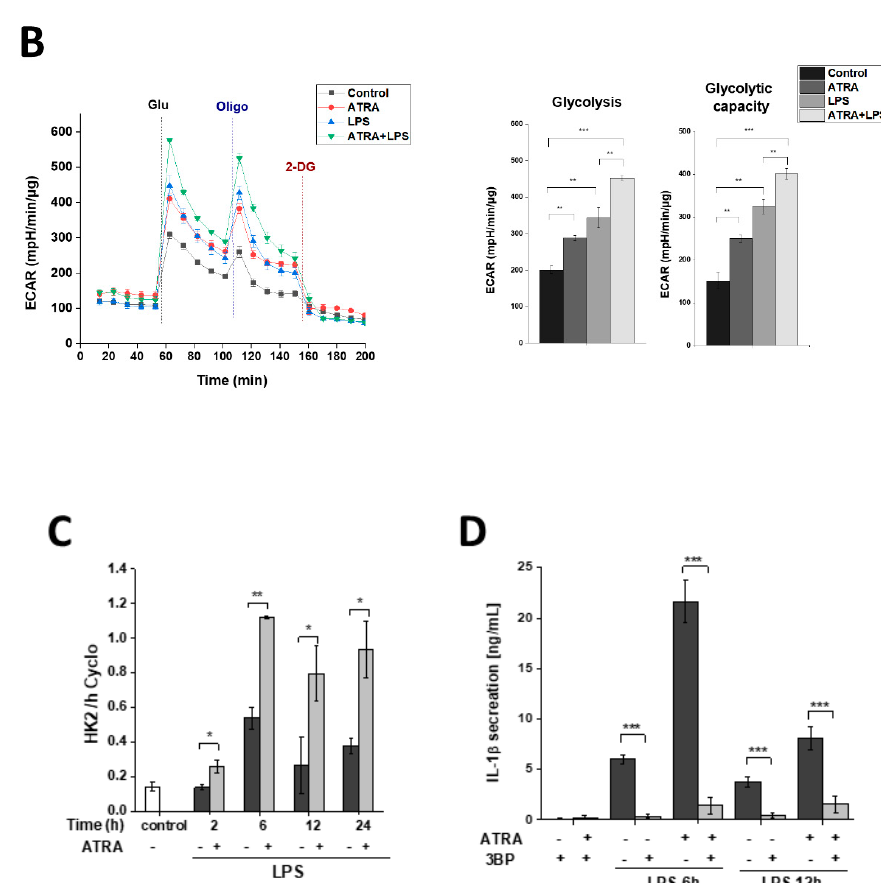
Figure 7. ATRA mediates metabolic changes in LPS-primed M Φ s. The cells were pre-treated with or without ATRA, then primed with LPS for 6 h, and subsequently subjected to the mitochondria stress test using a Seahorse XF96 Analyzer. ( A ) Real-time kinetics measurement of the oxygen consumption rate (OCR) during sequential treatment with oligomycin (Oligo), carbonylcyanide-4-(trifluoromethoxy) phenylhydrazone (FCCP), and antimycin A + rotenone (A + R). Representative results are shown. Bar graphs represent the calculated basal and maximal OCR, and ATP-coupled respiration and spare respiratory capacity. ( B ) Real-time kinetics measurement of the extracellular acidification rate (ECAR) after sequential treatment of glucose (Glu), oligomycin (Oligo), and 2-deoxyglucose (2-DG). Representative results are shown. Bar graphs represent calculated ECAR and glycolytic capacity obtained from the glycolytic stress test. Wave Desktop software was used for data analysis. ( C ) Relative gene expression of HK2 was measured by qPCR. The expression was normalized to the reference gene (human cyclophilin) expression. ( D ) M Φ s were pretreated with 3-bromopyruvate (3BP) (80 µM) 1 h before LPS priming and subsequently incubated with ATP (5 mM) for 45 min., and then the cell culture supernatants were collected, and the secretion of IL-1 β was assessed by ELISA. C, control (mock-treated cells). The data was obtained from at least four healthy donors. All results are shown as means ± SEM. (* p < 0.05, ** p < 0.01, *** p < 0.001). +, − , presence or absence of indicated substance, respectively